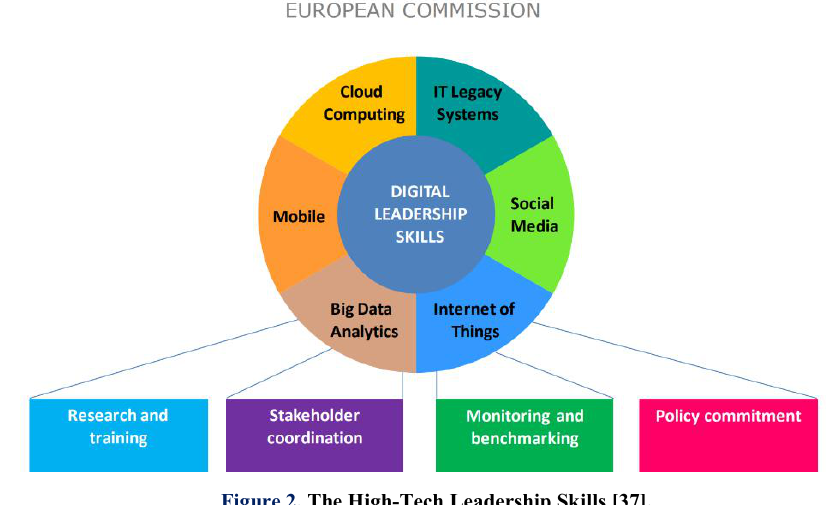
Figure 2. The High-Tech Leadership Skills